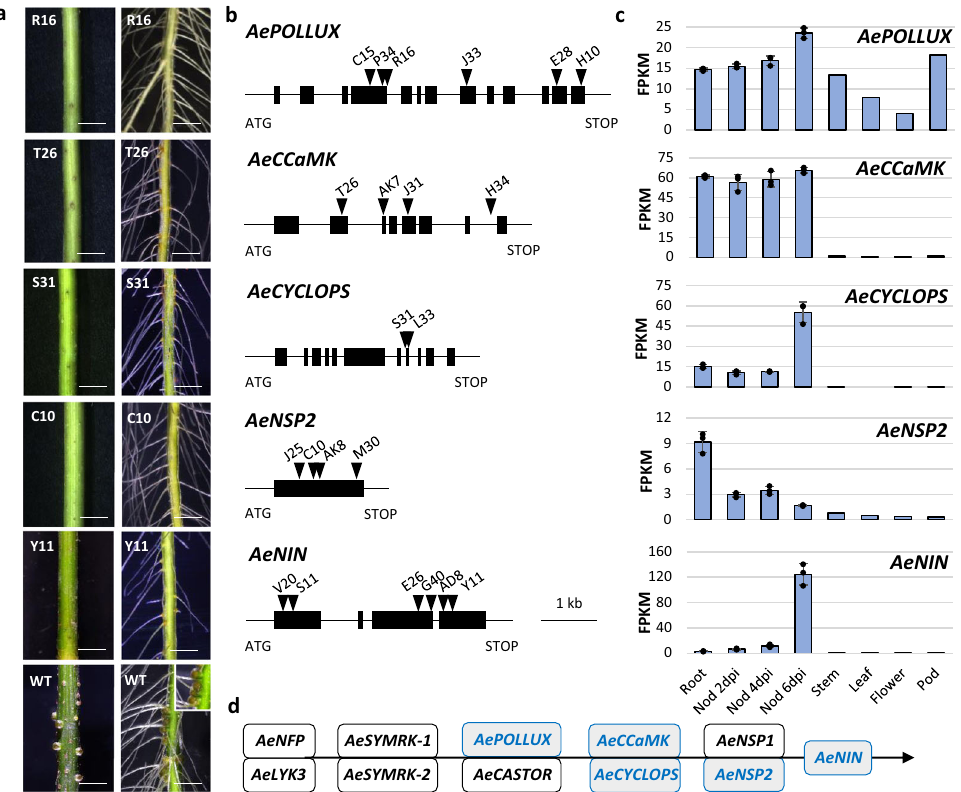
Fig. 6 Genes of the known symbiotic signaling pathway identi fi ed by targeted sequence capture. a Nodulation phenotypes observed on stem (left panel) and root (right panel) in EMS mutant plants and the WT line (bottom panels with inset corresponding to a zoom on root nodules). Root phenotypes were observed four times and stem phenotypes at least twice for each mutant. Scale bars: 5 mm. b Structure of the different symbiotic genes showing the position of the EMS mutations. Black boxes depict exons, lines represent untranslated regions and introns, and triangles represent mutation sites with the name of the corresponding mutant indicated above. c Expression pro fi les in A. evenia aerial organs, in roots, and in nodules (Nod) after 2, 4, and 6 days post-inoculation (dpi) with the Bradyrhizobium strain ORS278. Expression is given in normalized FPKM read counts. For root and nodule samples, data correspond to mean values of three biological replicates ± SEM and dots represent individual expression levels. d Representation of the symbiotic signaling pathway as inferred from model legumes. Genes in blue are those demonstrated as being involved in the Nod factor-independent signaling in A. evenia using the mutant approach. Source data underlying ( c ) are provided as a Source Data fi